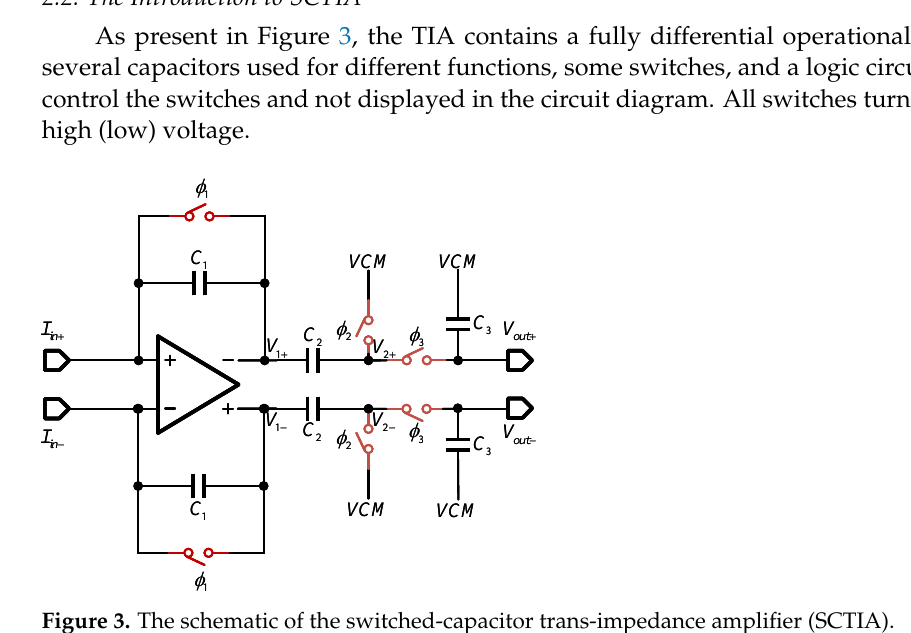
Figure 3. The schematic of the switched-capacitor trans-impedance amplifier